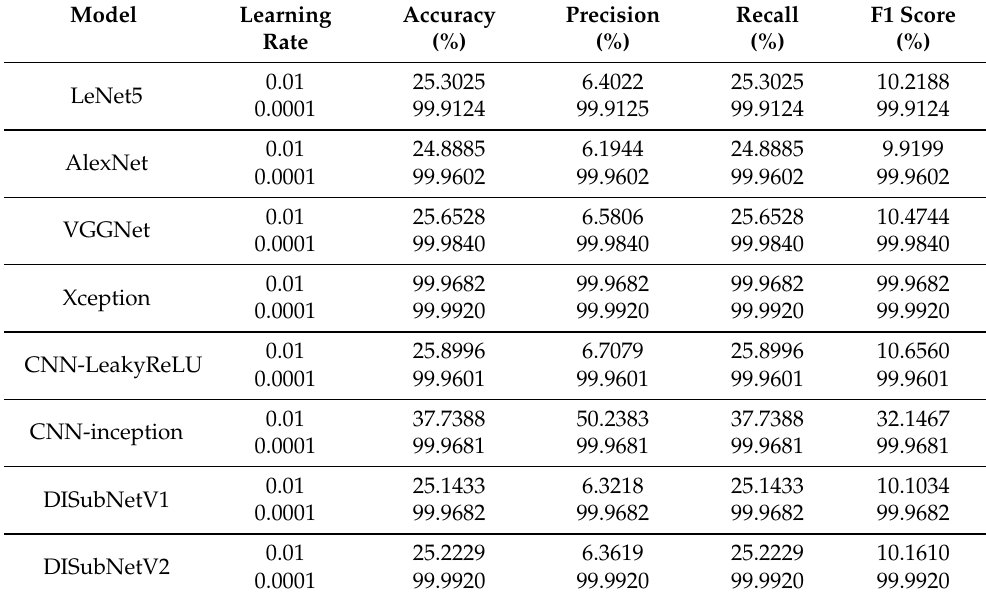
Table 2. Comparison of all models with different learning rates. Model Learning Accuracy Precision Recall F1 Score Rate (%) (%) (%)